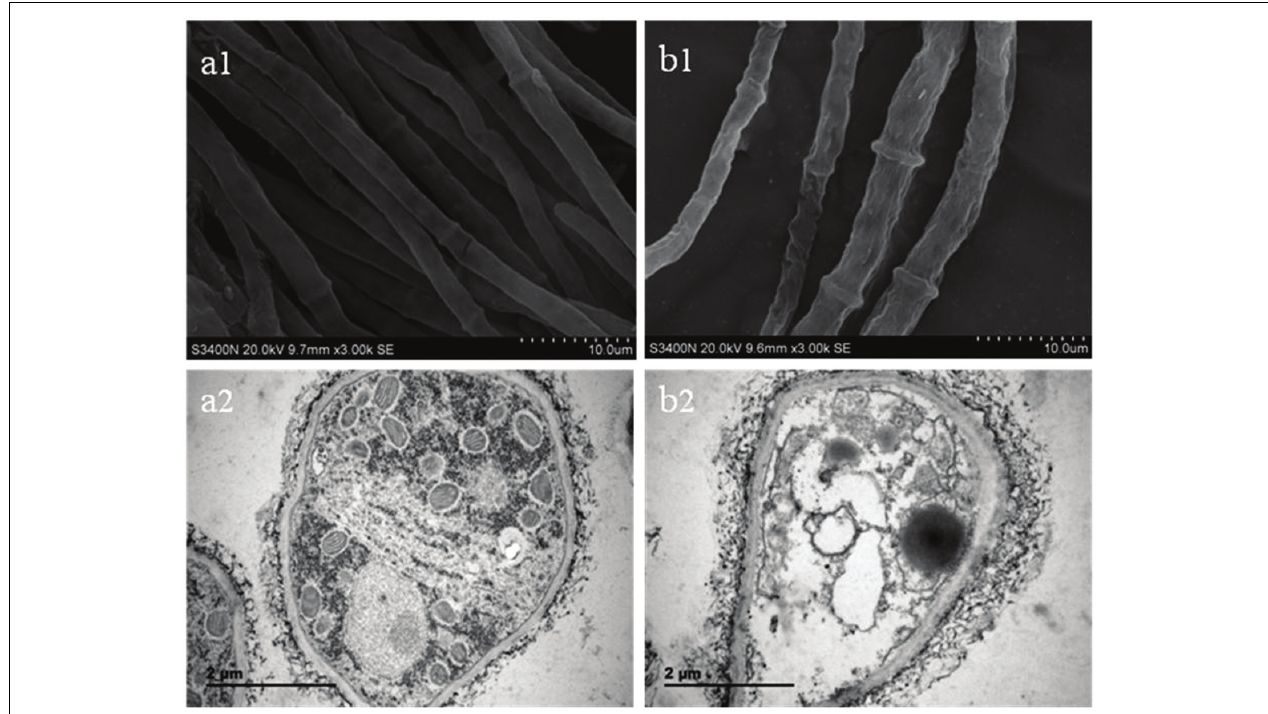
FIGURE 2 | Images obtained by scanning electron microscopy (SEM) and transmission electron microscopy (TEM) for B. cinerea treated with SCLEO. First row: SEM images ( × 3000) of morphology in hyphae. (a1) Healthy hyphae control. (b1) hyphae treated with SCLEO. Second row: TEM images ( × 25000) of hyphal ultrastructure. (a2) Healthy hyphae control. (b2) Hyphae treated with SCLEO.